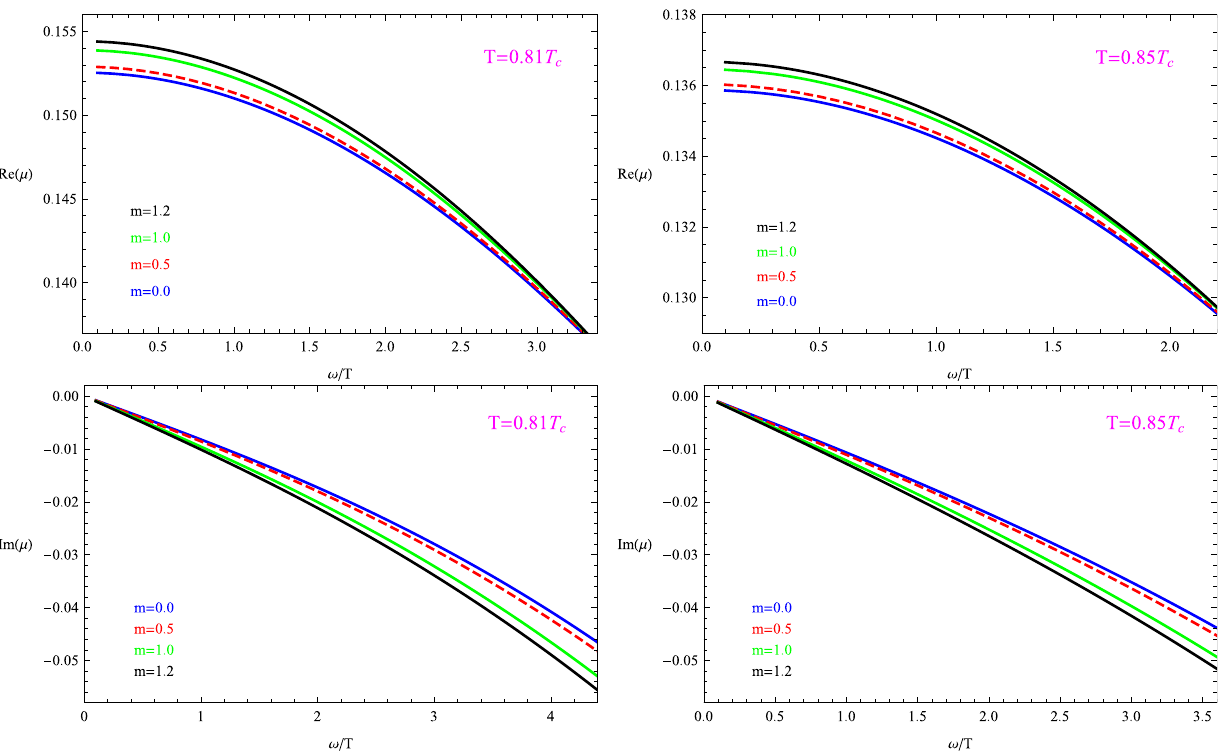
Fig. 4 Real (top) and imaginary (bottom) parts of the permeability μ as a function of ω/ T with the fixed temperatures T = 0 . 81 T c (left) and T = 0 . 85 T c (right) for different values of the graviton mass parame-